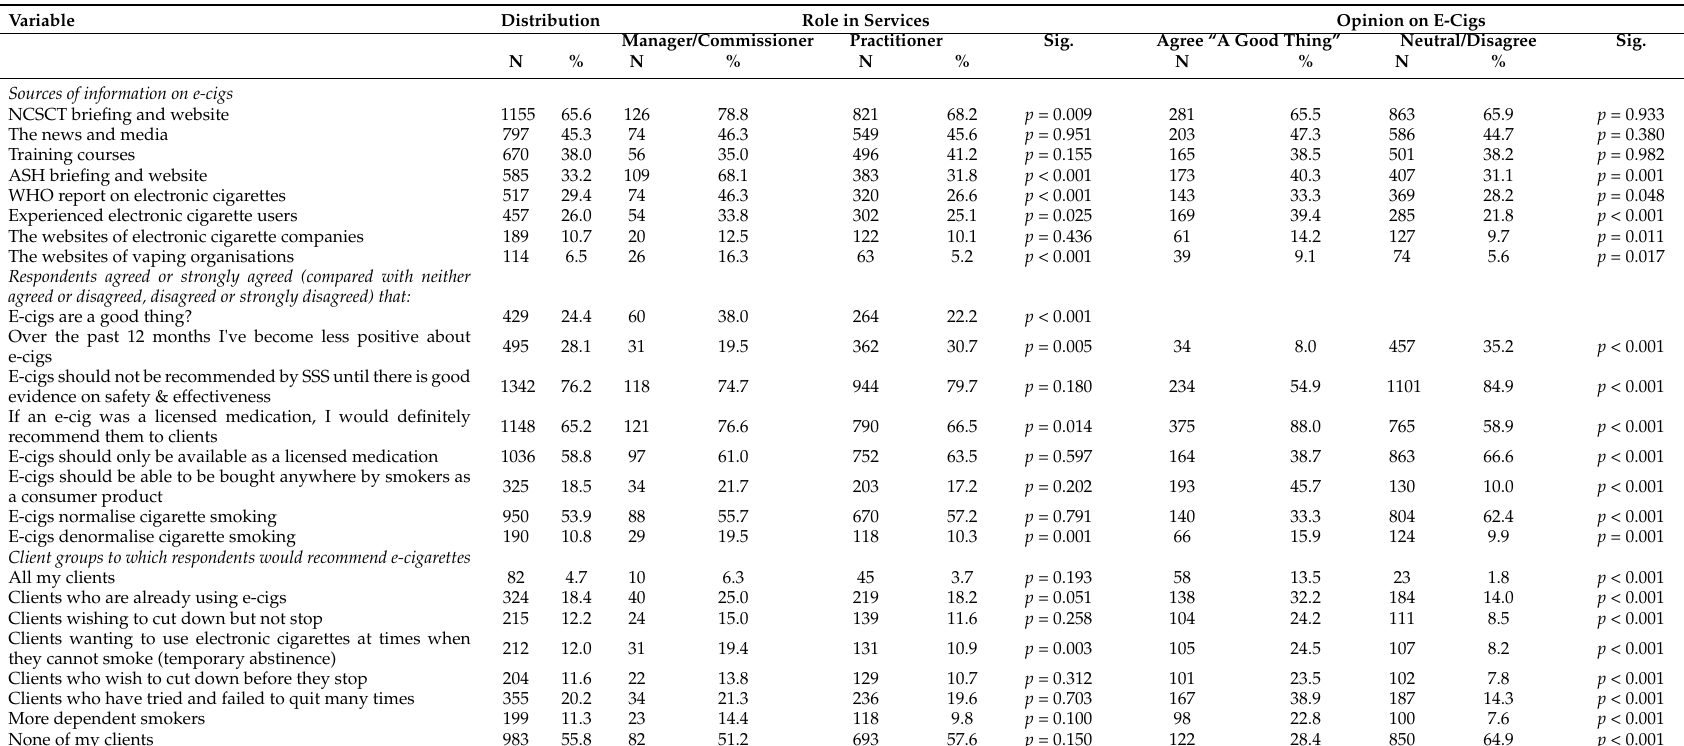
Table 2. Respondent knowledge and attitudes by role in services and opinion on